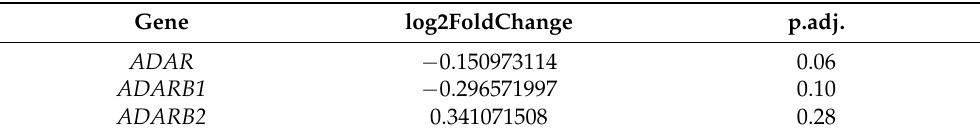
Table 2. Differential expression analysis of RNA-specific adenosine deaminases in PD patients’ brains versus the healthy control.